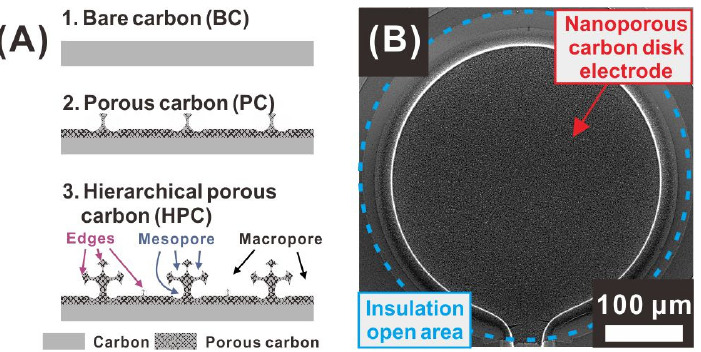
Figure 2. ( A ) Schematic sectional views of nanoporous carbon electrodes, according to their porosity. ( B ) Scanning electron microscopy image of a hierarchical porous carbon (HPC) disk electrode.